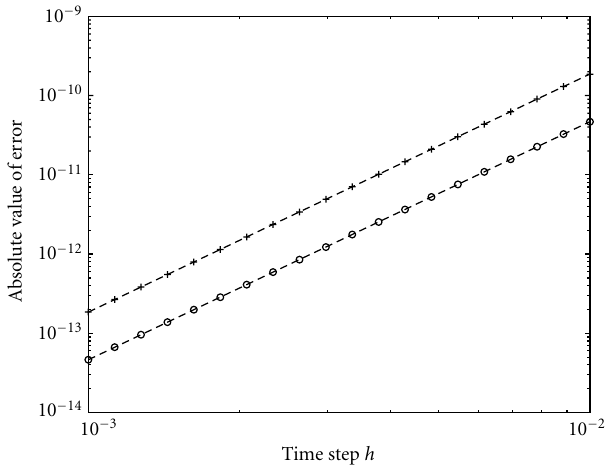
Figure 3.3. Absolute value of error at t = 10 in solution of (3.1) versus step size. The pluses show results for the accelerated RK3 scheme using the parameters given in (2.9b) and the circles show the standard RK3.